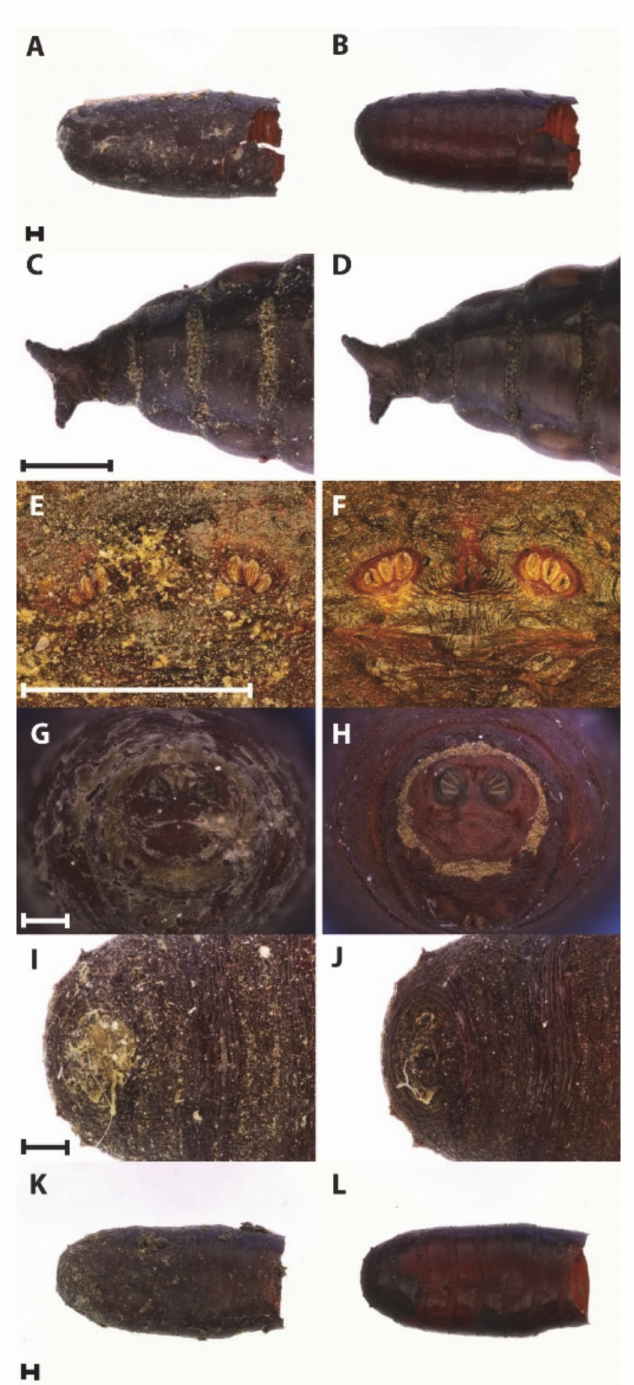
Figure 1. Puparia before and after treatment: ( A , B ) Water and soap solution, ( C , D ) Glacial Acetic Acid, ( E , F ) Sonication; ( G , H ) Sodium hydroxide 10% solution, ( I , J ) Hydrochloric acid/sodium bicarbonates solutions, ( K , L ) Sodium hypochlorite 1–5% solution. Scale bars: 500 µ